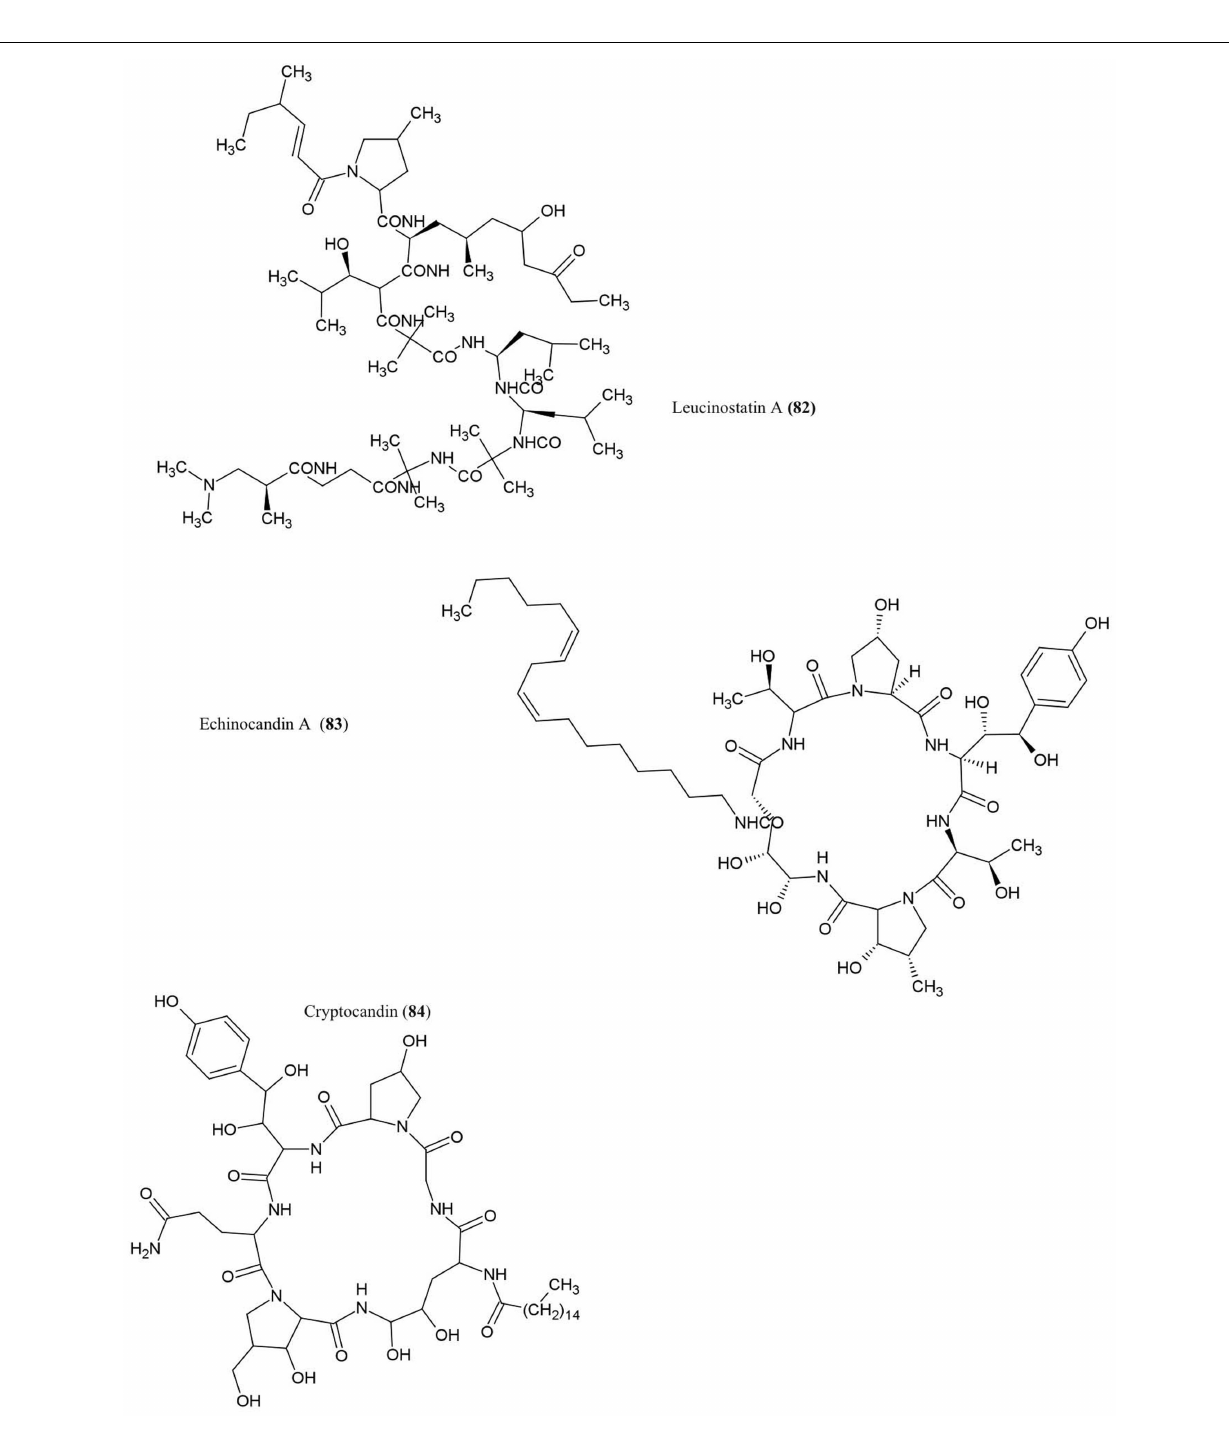
FIGURE 8 | Structures of peptides derivatives of fungal endophyte origin